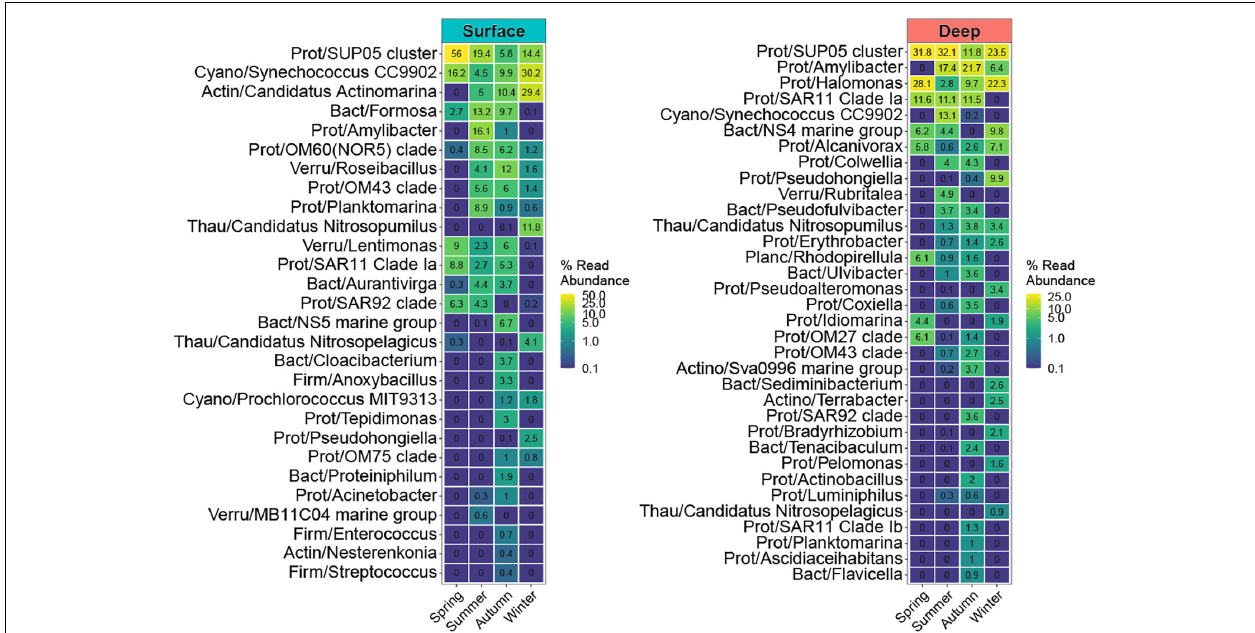
FIGURE 4 | Prokaryotic community members associated with surface and deep (500 m) water seasonality. Seasonally changing taxa were determined from a generalised linear model generated from every combination pairing of meteorological seasons for surface and deep communities separately, collected over 3 years from the Munida Microbial Observatory Time-Series (MOTS). A total of 28 seasonal ASVs were found for the surface and 34 for deep waters, identified here at genus level where possible.